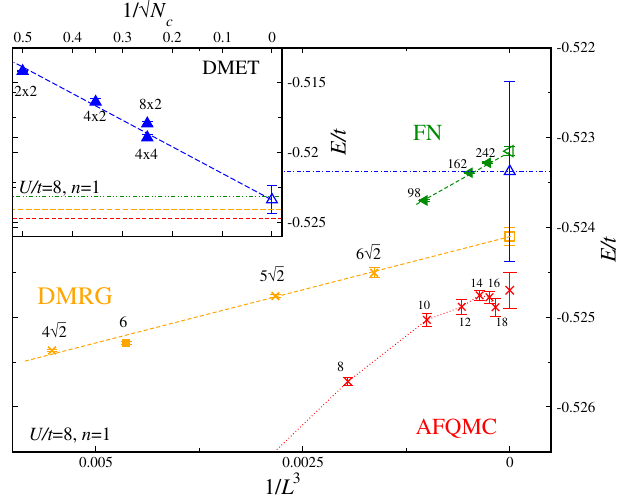
FIG. 1. Extrapolations of the ground-state energy at U=t ¼ 8 , n ¼ 1 . Main panel: AFQMC and FN extrapolated as a function of the inverse cube of the system ’ s linear dimension L along with DMRG extrapolated in the cube of the inverse cylinder circum- ference (also denoted L ). DMRG data are presented both for ffiffiffi p 2 rotated (with ) and unrotated wrapping of cylinders. Inset: DMET data for clusters of size and geometry indicated, plotted against the reciprocal of the square root of the total number of sites in the cluster N c